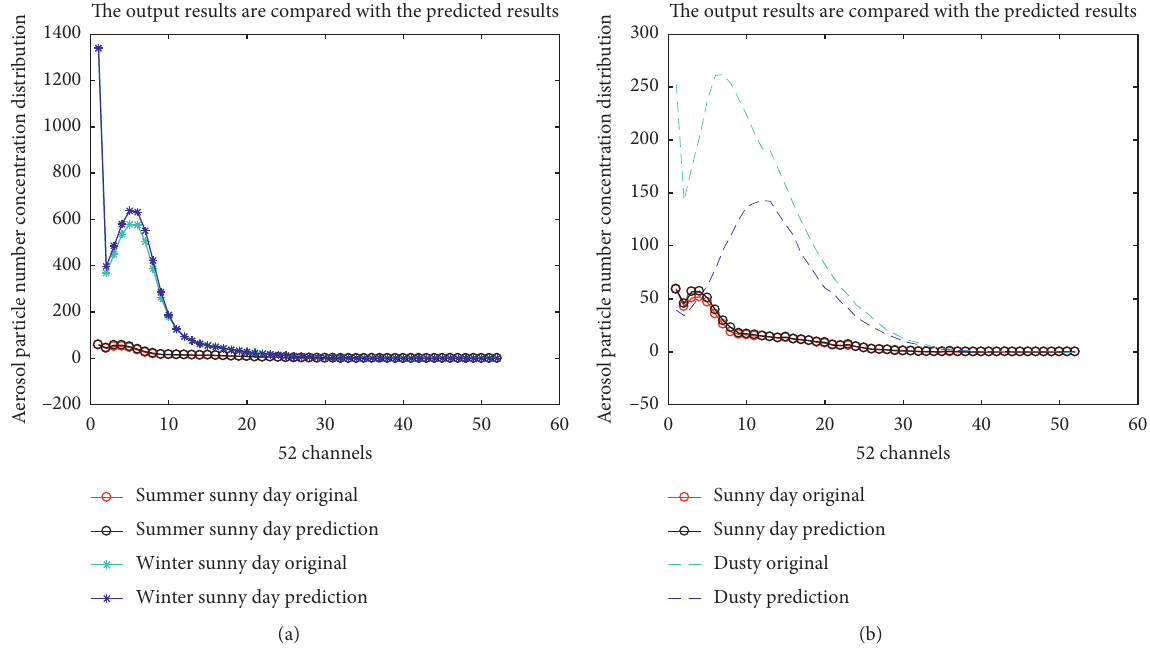
Figure 8: The comparison between prediction results and measured results on sunny, winter sunny days, and dusty days based on RBF neural network.